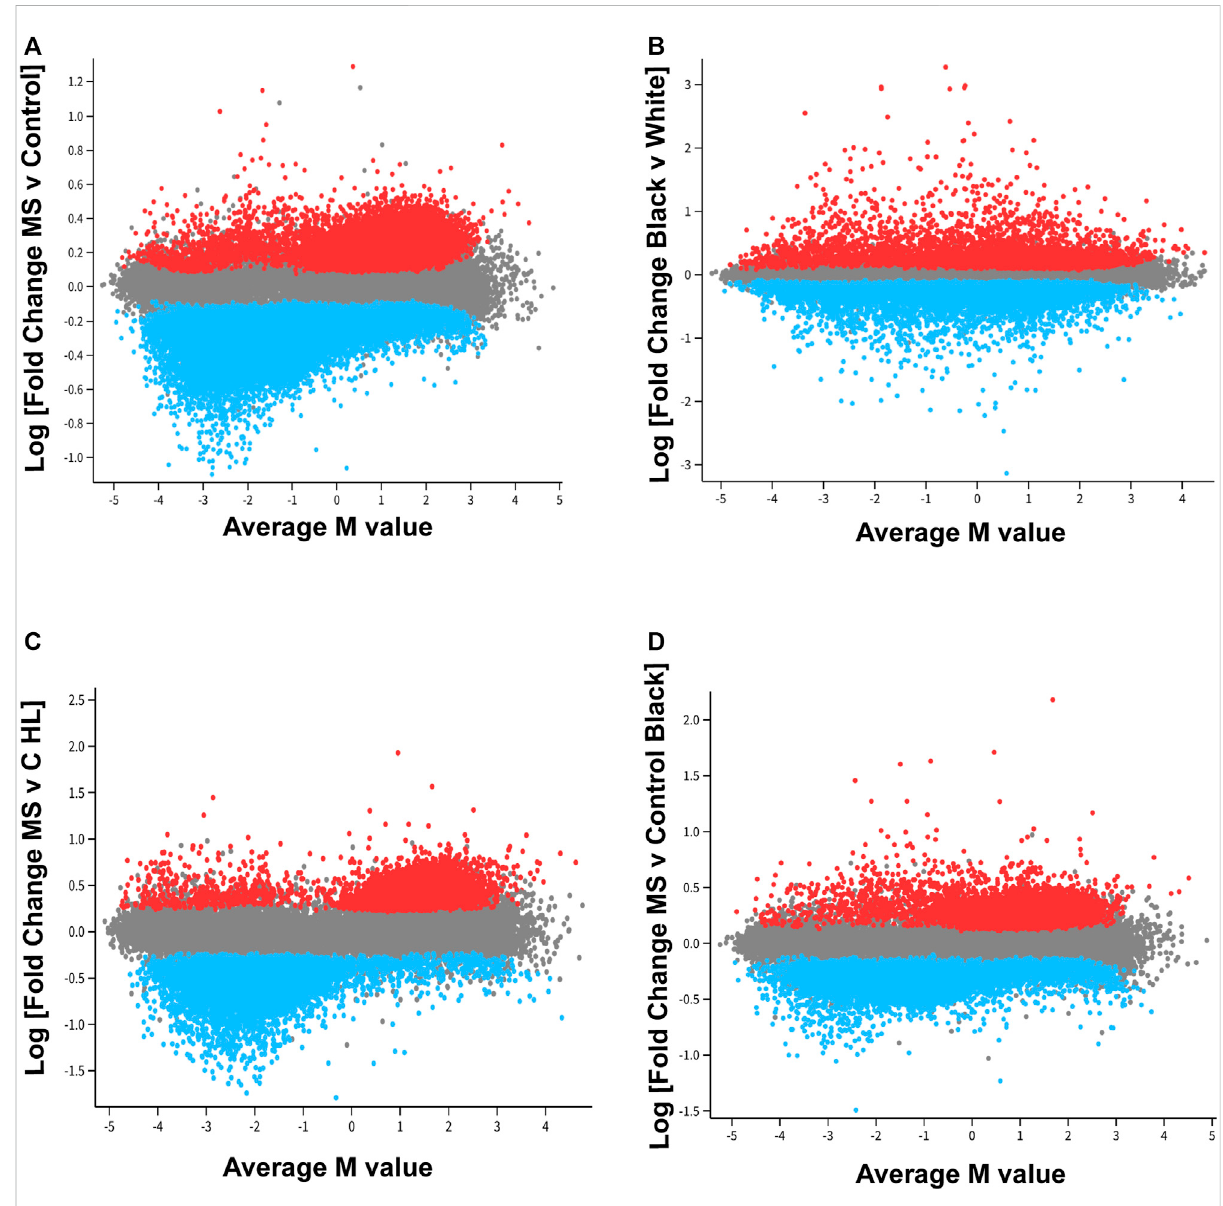
FIGURE 1 Distinct pattern of differential methylation of genomic DNA associated with MS. In the mean difference (MD) plots, average M-values across all donors is plotted on the x-axis. A negative number on the x-axis indicates decreased methylation for that locus [differentially methylated probe, DMP; CpG region), whereas as a positive number designates increased methylation as compared to other loci. Log fold change is plotted on the y-axis. (A) ] For the MS versus control comparison, 52,295 DMP ’ s were included in this analysis (FDR < 0.01). An additional 20,000 probes were randomly selected for inclusion in the plot (gray). Red points designate probes that showed a relative increase in methylation MS as compared to controls, and blue points represent probes that demonstrated a relative decrease in methylation in the MS group. Two trends were observed. For those probes with the greatest fold change differences [Log (FC) > 0.7 or < − 0.7, fold change of greater 5×, FDR < 0.01], these differences primarily re fl ected decreased methylation of those DMP ’ s with lower average M-values (M value < 0; blue, left lower quadrant). If a less stringent cut off was usedforfoldchange,theresultssuggested atendencyfor signi fi cantDMP ’ sthat hadanaveragemethylationscore over50%(AverageMvalue > 0)to be hypermethylated in MS patients, and signi fi cant probes that had an average methylation below 50% to be hypomethylated in MS patients. (B) These trends were not observed in a comparison of all Black donors versus all White donors. The racial differences showed a more normalized distribution of relative increases or decrease in probe methylation as compared to the MS versus control analysis. (C,D) . MD plots were also performed in racial and ethnic subgroups. The trend observed in the MS versus control comparison was most pronounced in the Hispanic-Latino